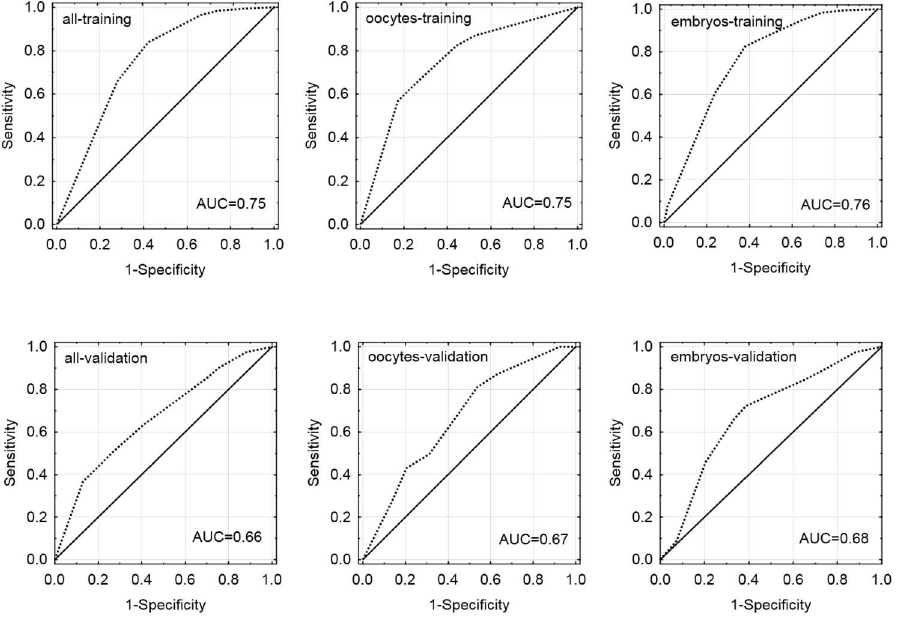
Figure 4. ROC curves of trees 1–3 for training and validation